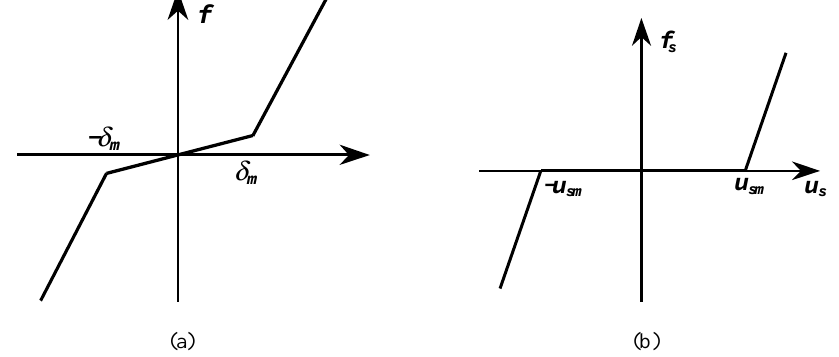
Fig. 2. Bilinear force-deformation diagram for the equivalent springs (a) at the roller guide assemblies, and (b) at the contact point of the counterweight frame with the